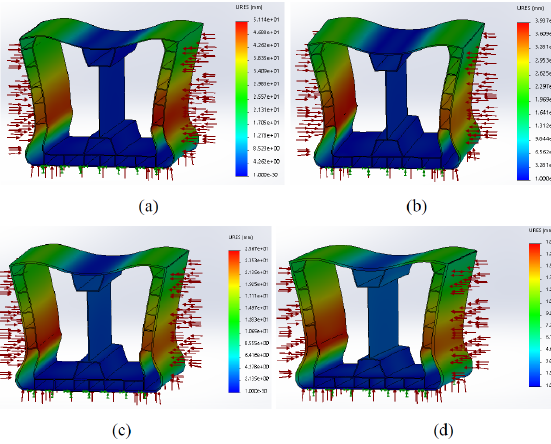
Figure 10: Deformation contour plots at various plate thicknesses: (a) 100 mm, (b) 150 mm, (c) 200 mm, and (d) 250